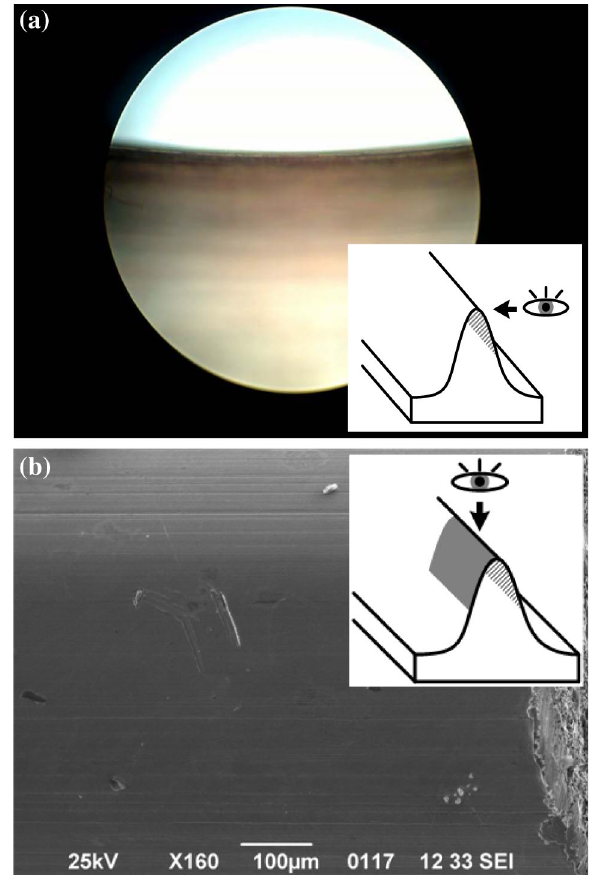
FIG. 6. Photographs of the central part of the waistband before FEM irradiation: (a) optical microscope and (b) electron micro- scope (magnification of 160).